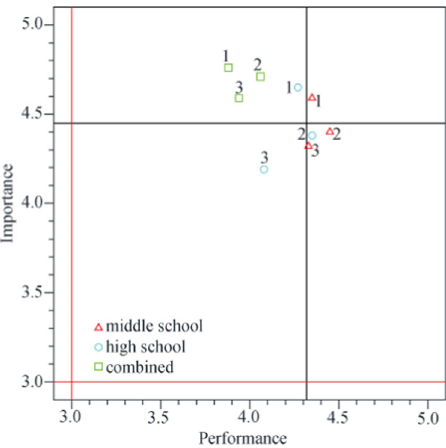
Fig. 6 IPA values of “ opinions regarding the STEM-ED empowerment course ” the different age groups taught. The mean score on question 15 among teachers in the combined group is much lower than ≪ the other scores.